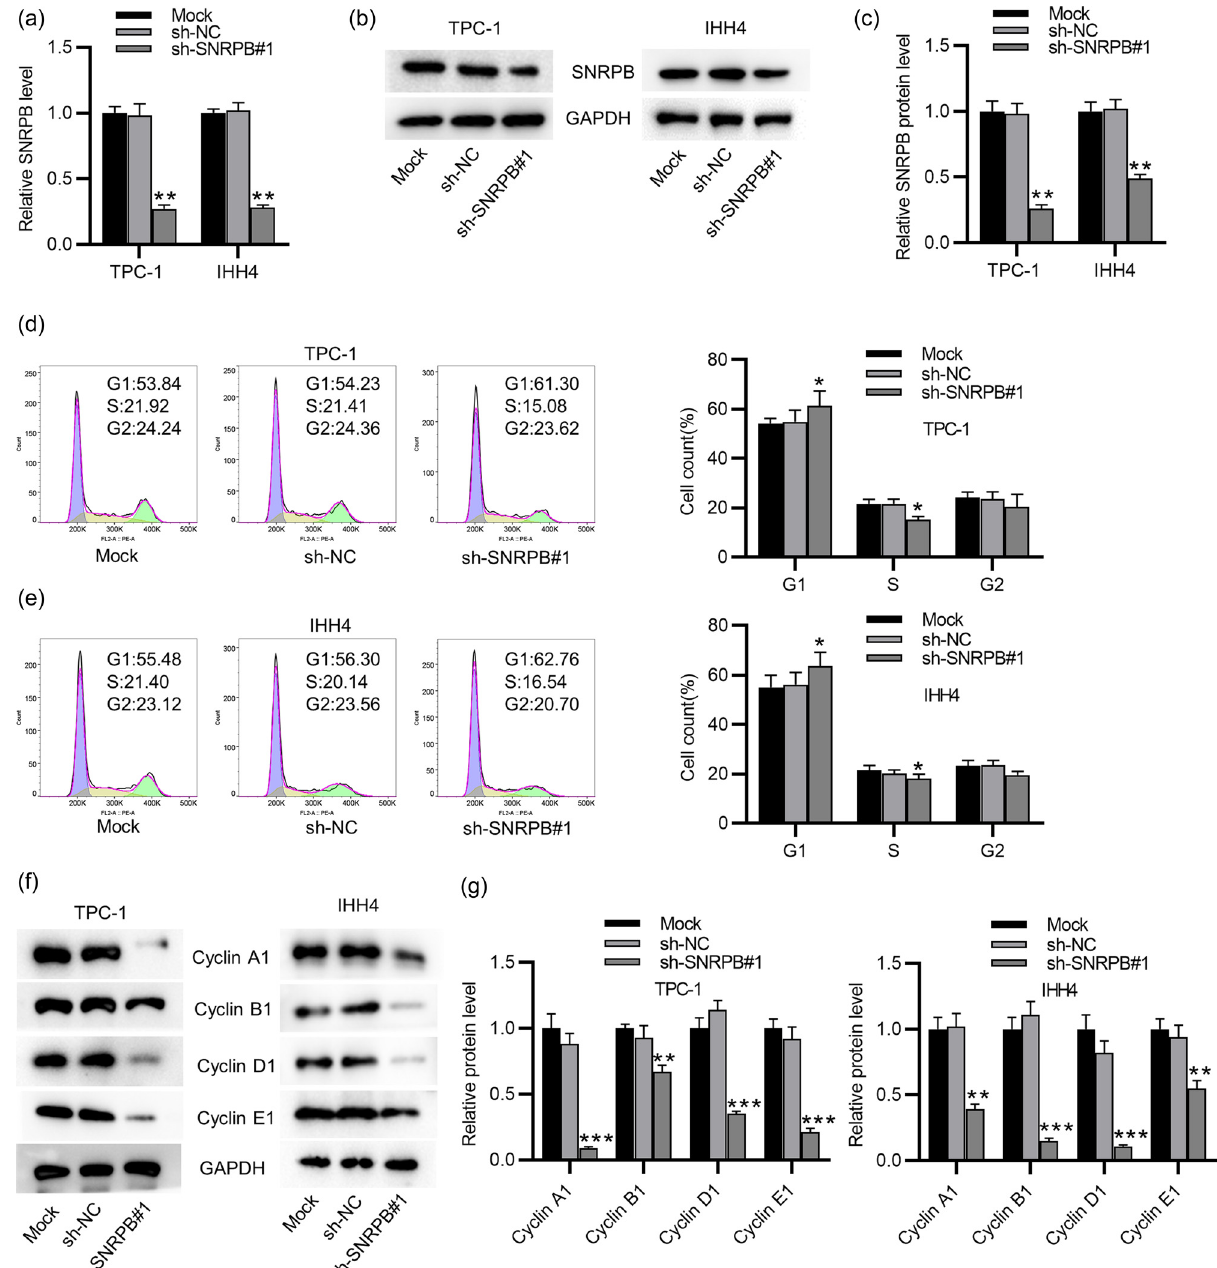
Figure 2: SNRPB knockdown induces G1 phase arrest in PTC cells: ( a – c ) RT - qPCR and western blotting for evaluating e ffi ciency of SNRPB knockdown in PTC cells ( TPC - 1, IHH4 ) , ( d and e ) fl ow cytometry for determining cell cycle distribution of PTC cells with treatment of mock, sh - NC or sh - SNRPB#1 and ( f and g ) western blotting for assessing levels of cell cycle - associated proteins in indicated PTC cells.